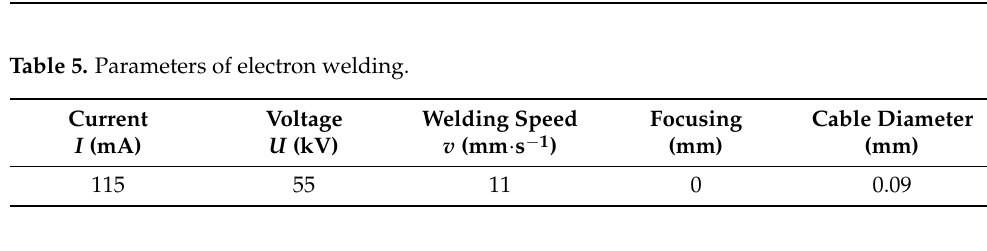
Table 6. Parameters of MAG welding